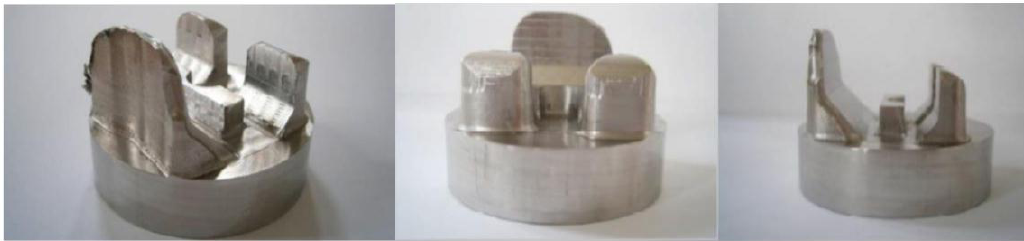
Figure 6. Views of the workpiece after the first machining stage.